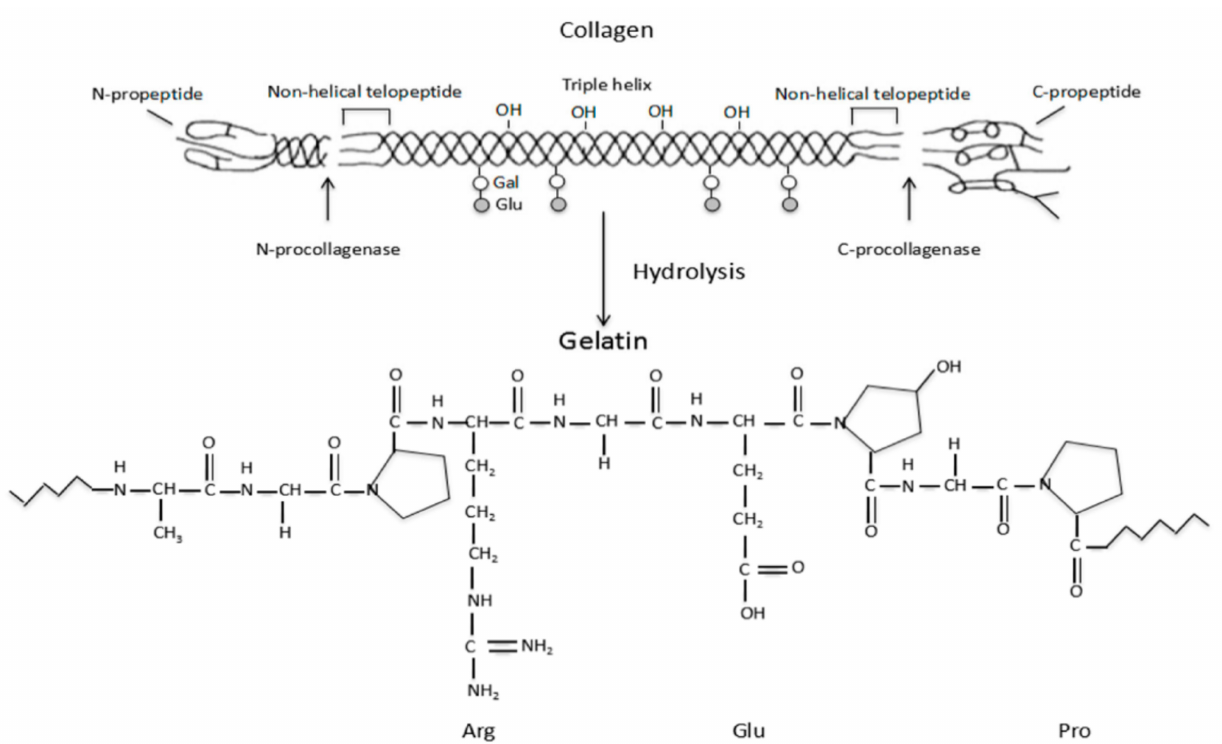
Figure 2. Schematic representation of the collagen hydrolysis to gelatin. Reprinted with permission from [46]. Copyright 2017, MDPI. Distributed under Creative Commons Attribution—based license (CCBY